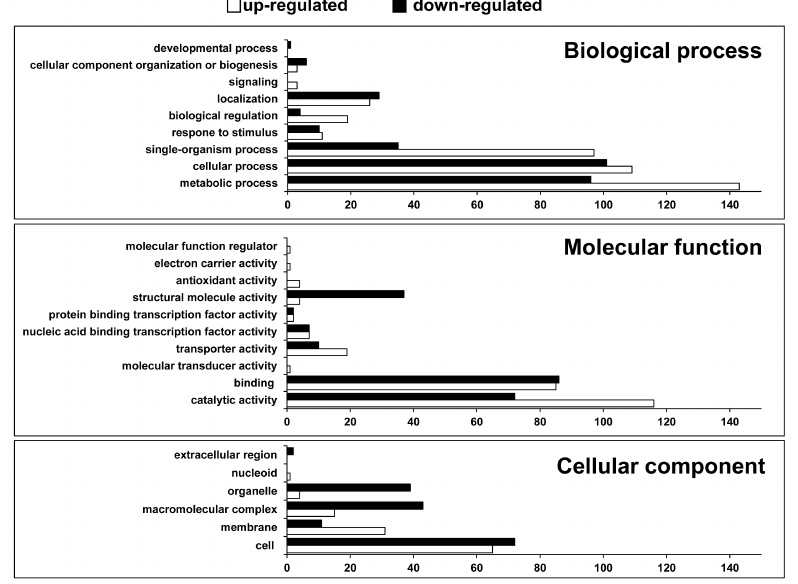
Figure 2. Functional categorization of up- and downregulated genes in Corynebacterium glutamicum